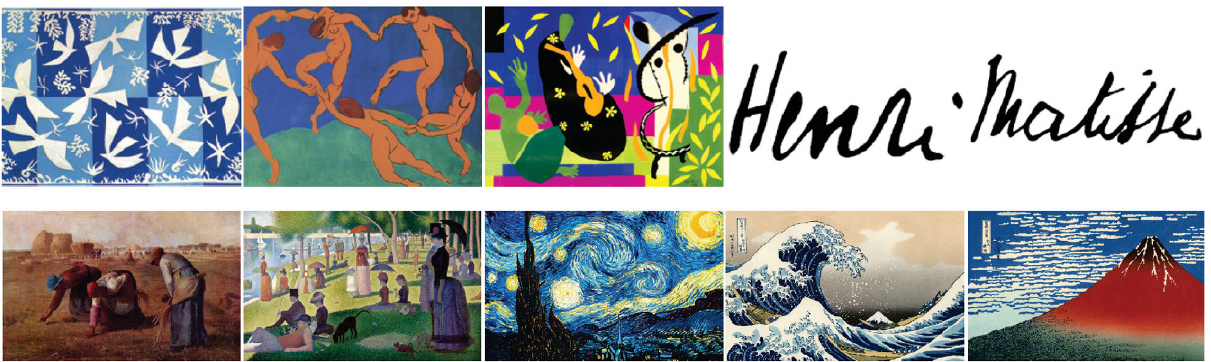
Fig. 11 Top: input images for Fig. 6. The original images are 240 × 180 pixels. Bottom: input images for Figs. 4 and 7. The original images are 600 × 375 pixels. From left to right, share I 1 , common share I c , share I 2 , secret I S